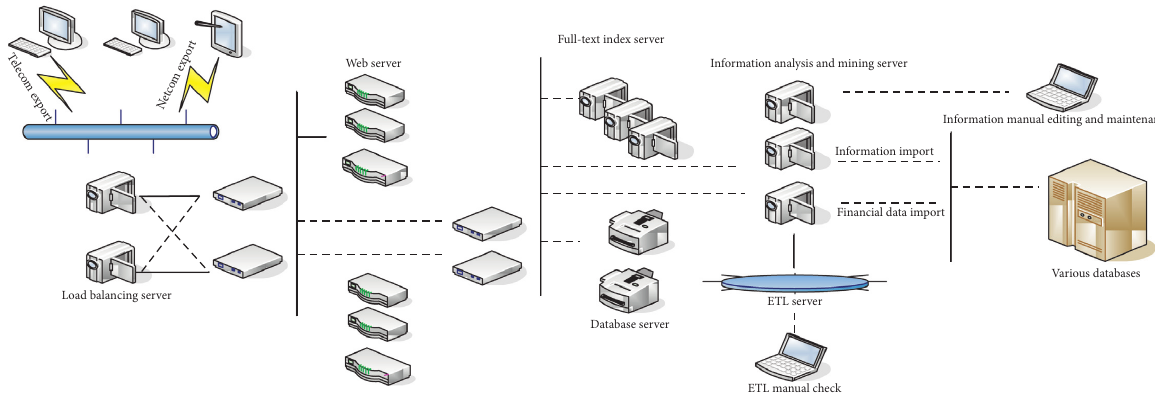
Figure 1: ITINN diagram of financial cloud computing framework